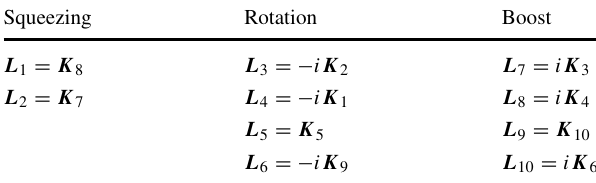
Table 2 Generators of the helicity basis S p ( 4 , R ) in the fundamental representation, L i = U K i U † , where the K i generators are given in Table 1 Squeezing